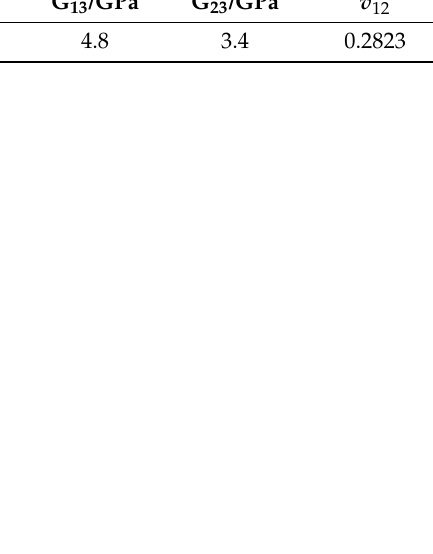
Figure 13. Loading and boundary